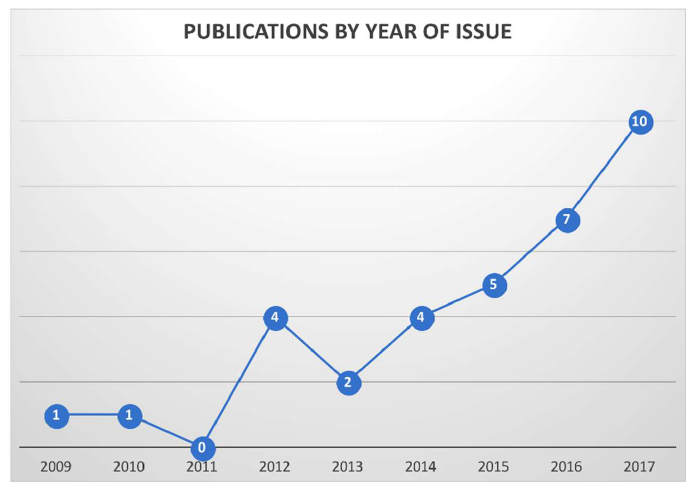
Figure 2. Temporal distribution of the selected studies. Nearly half of the computational studies were published in the last two years.